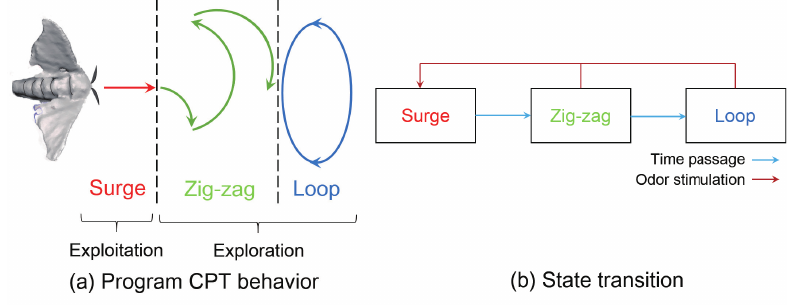
Figure 5. CPT behavior of a male silkworm